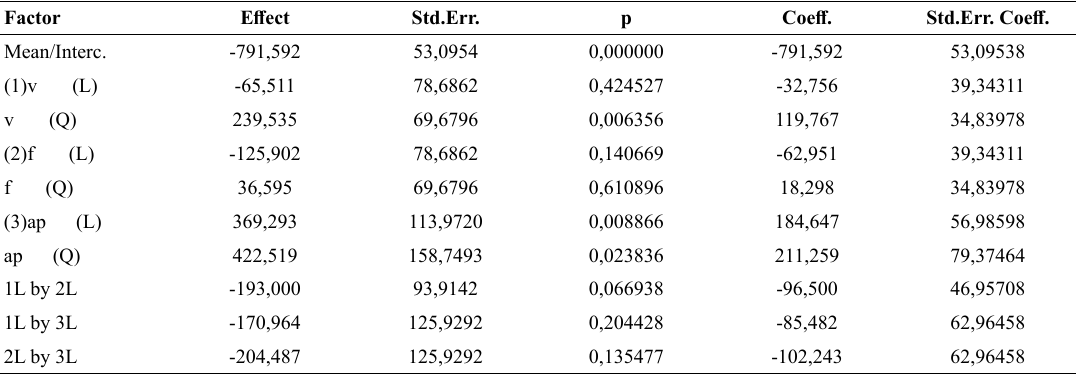
Table 8. ANOVA for the effect of the independent variables on circumferential residual stress. Factor Effect Std.Err. Std.Err. Coeff.